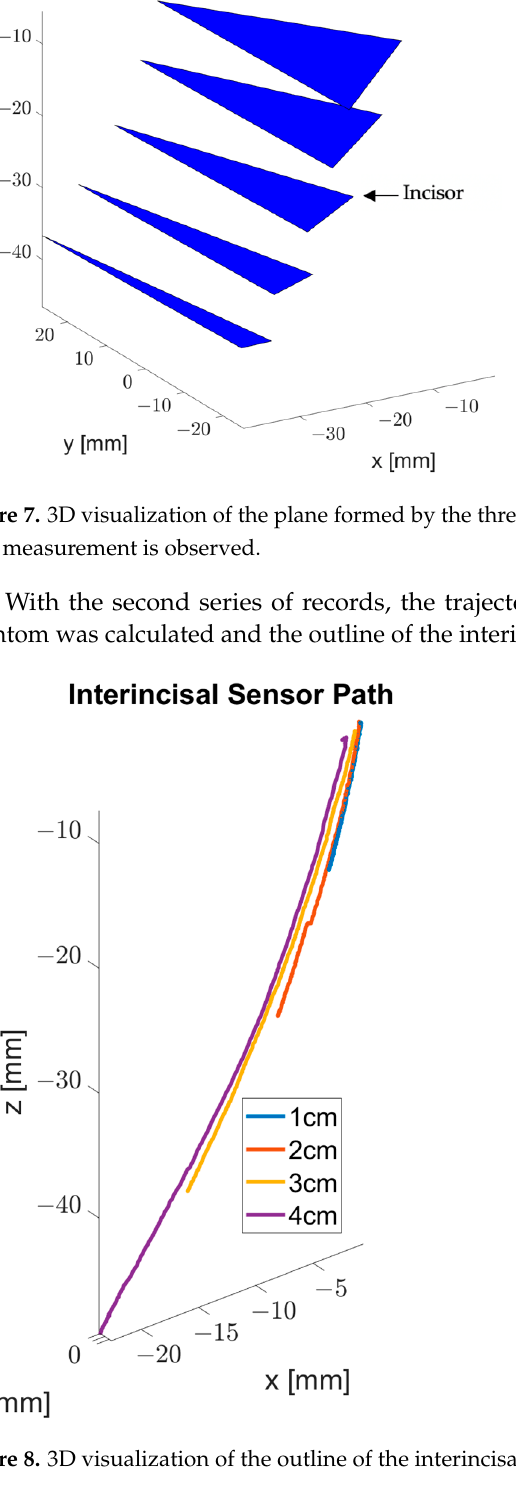
Figure 6. Parameters Euclidean distance (d), and vertical range (dz).